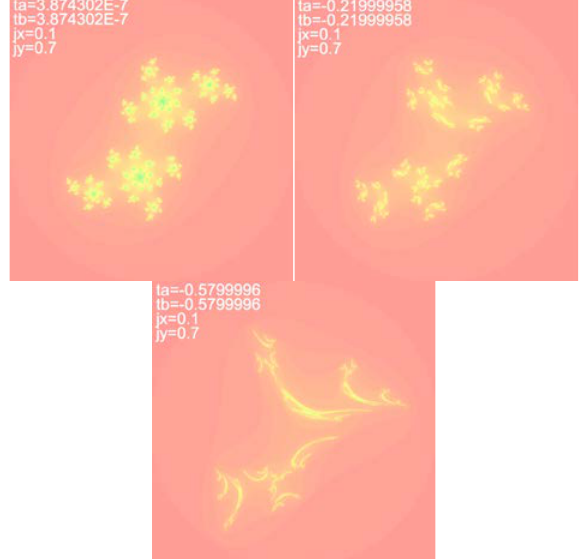
Fig.1. Three frame from the animation showing gradual change of Julia set with the deviation of complex analyticity. Parameters of the map is shown in the pictures. Here jx is real, and jy is the imagery parts of c, ta and tb represents a and b (they are equal for the Packham map). Left panel is the analytic map